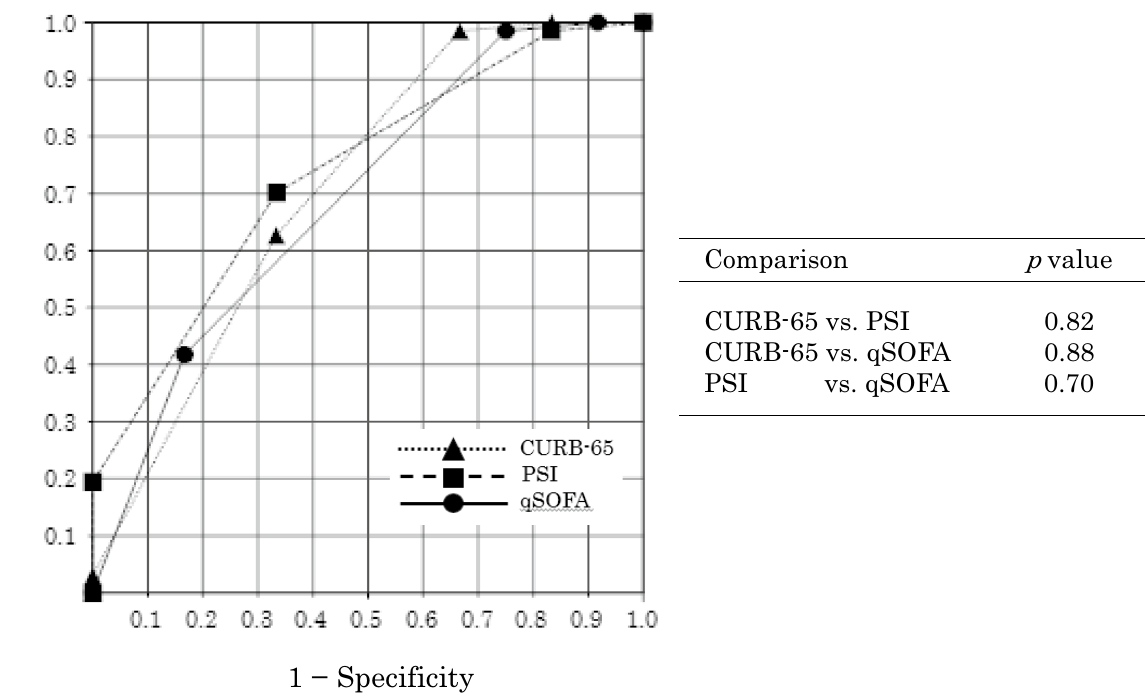
Figure 1. Comparison of the receiver operating characteristic (ROC) curves of the CURB-65, PSI, and qSOFA scoring systems for predicting pneumonia mortality in hospitalized patients with IPF. CURB-65 Confusion, Urea, Respiratory Rate, Blood Pressure and Age; PSI Pneumonia Severity Index; qSOFA quick Sequential Organ Failure Assessment.